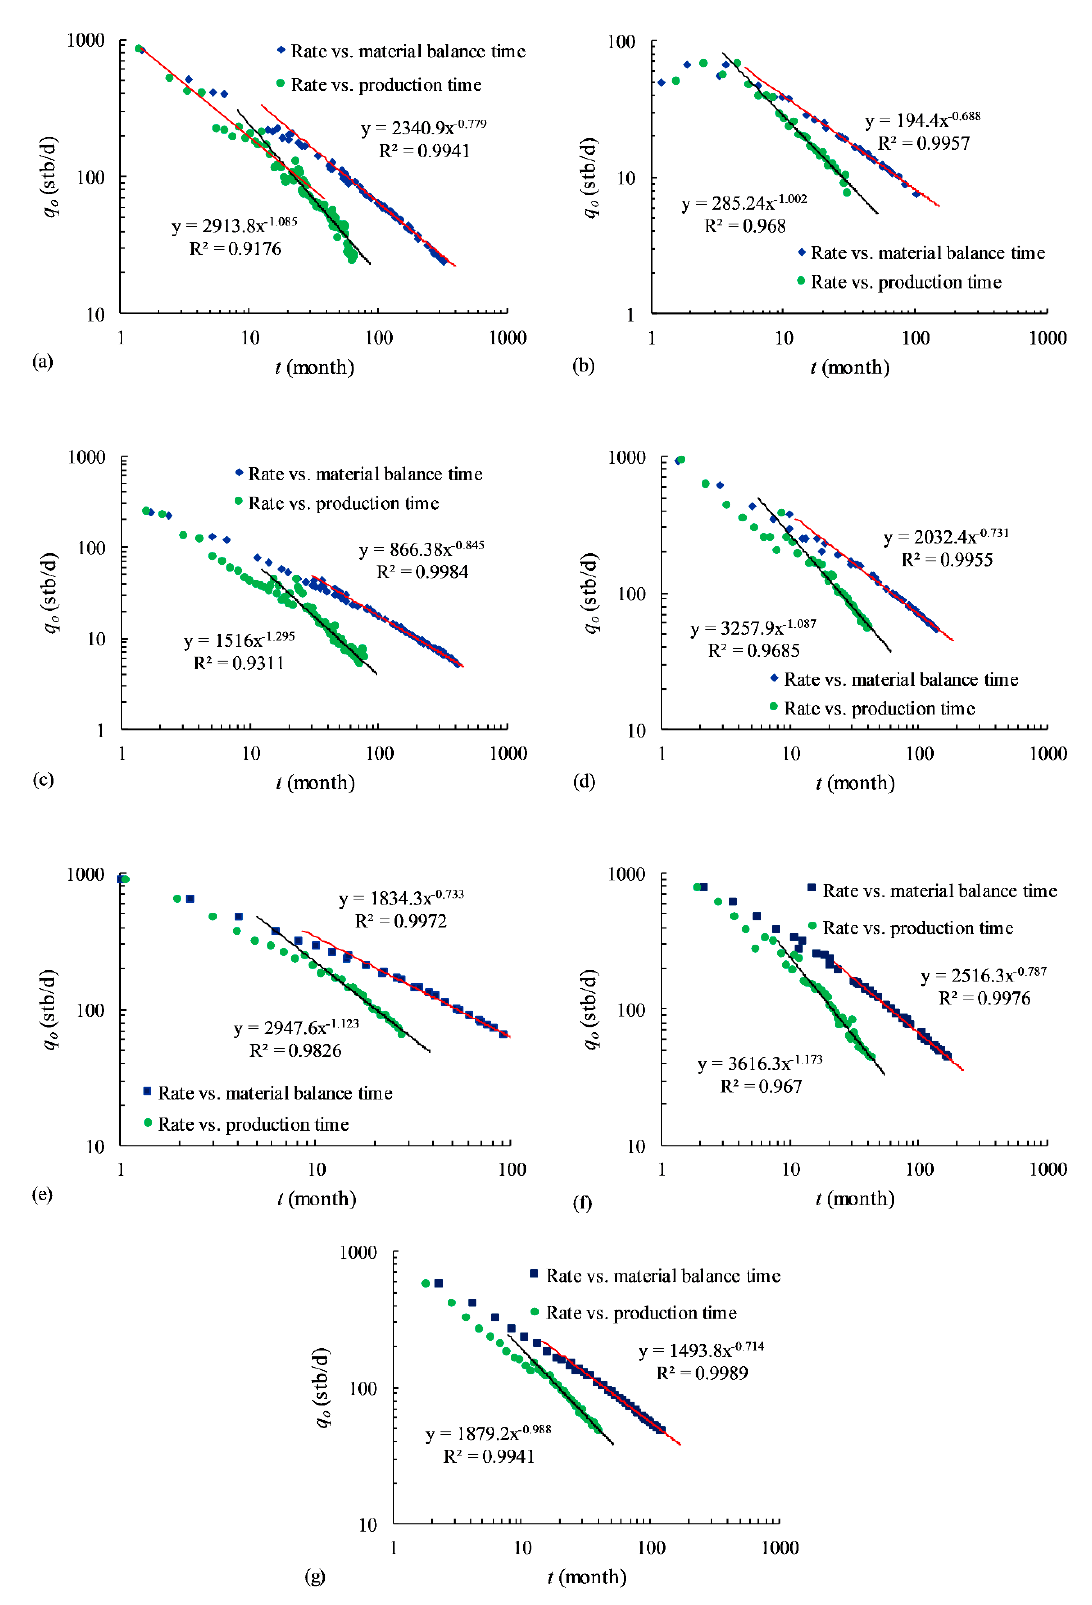
Figure 3. Log-log diagnostic plot of TMS wells. ( a ) well 1. ( b ) well 2. ( c ) well 3. ( d ) well 4. ( e ) well 5. ( f ) well 6. ( g ) well 7.